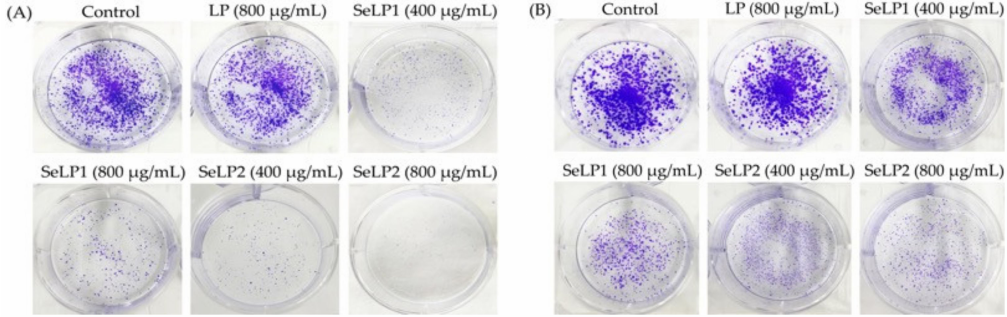
Figure 3. Long-term anti-proliferation of longan polysaccharides (LP) and the two selenylated polysaccharides (SeLP1 and SeLP2) on HT-29 cells with treatment times of 14 ( A ) and 21 days ( B ).